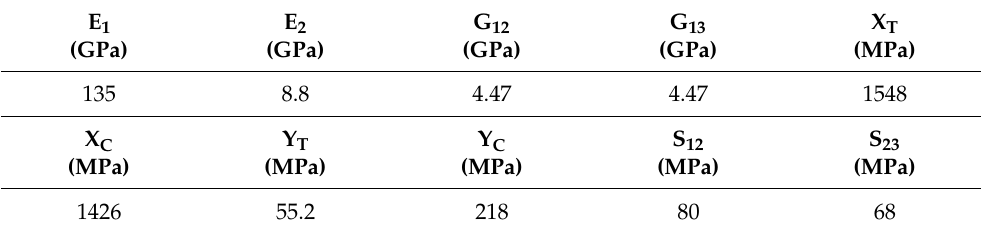
Table 1. Performance Parameters of T300/BA9913 Composite.